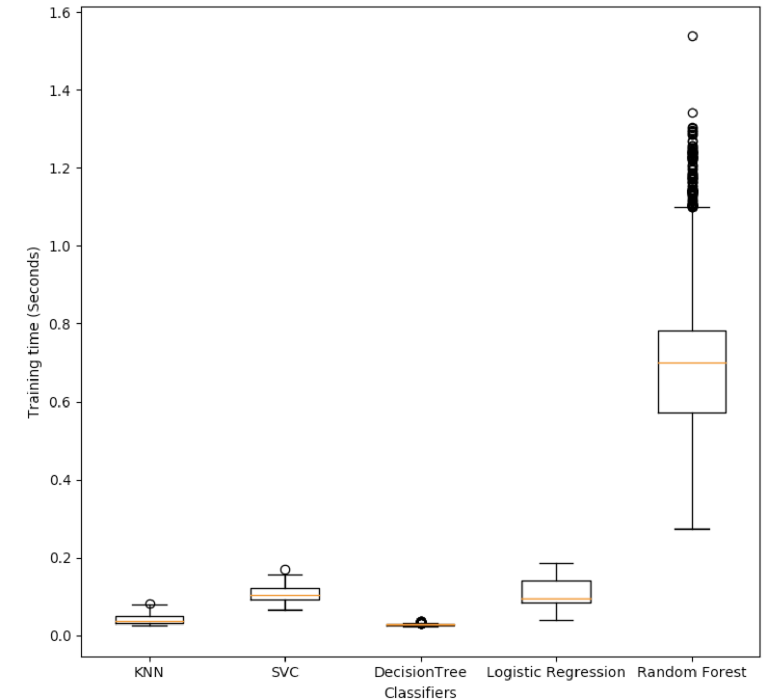
Figure 3. The classifiers’ training time for all the users.